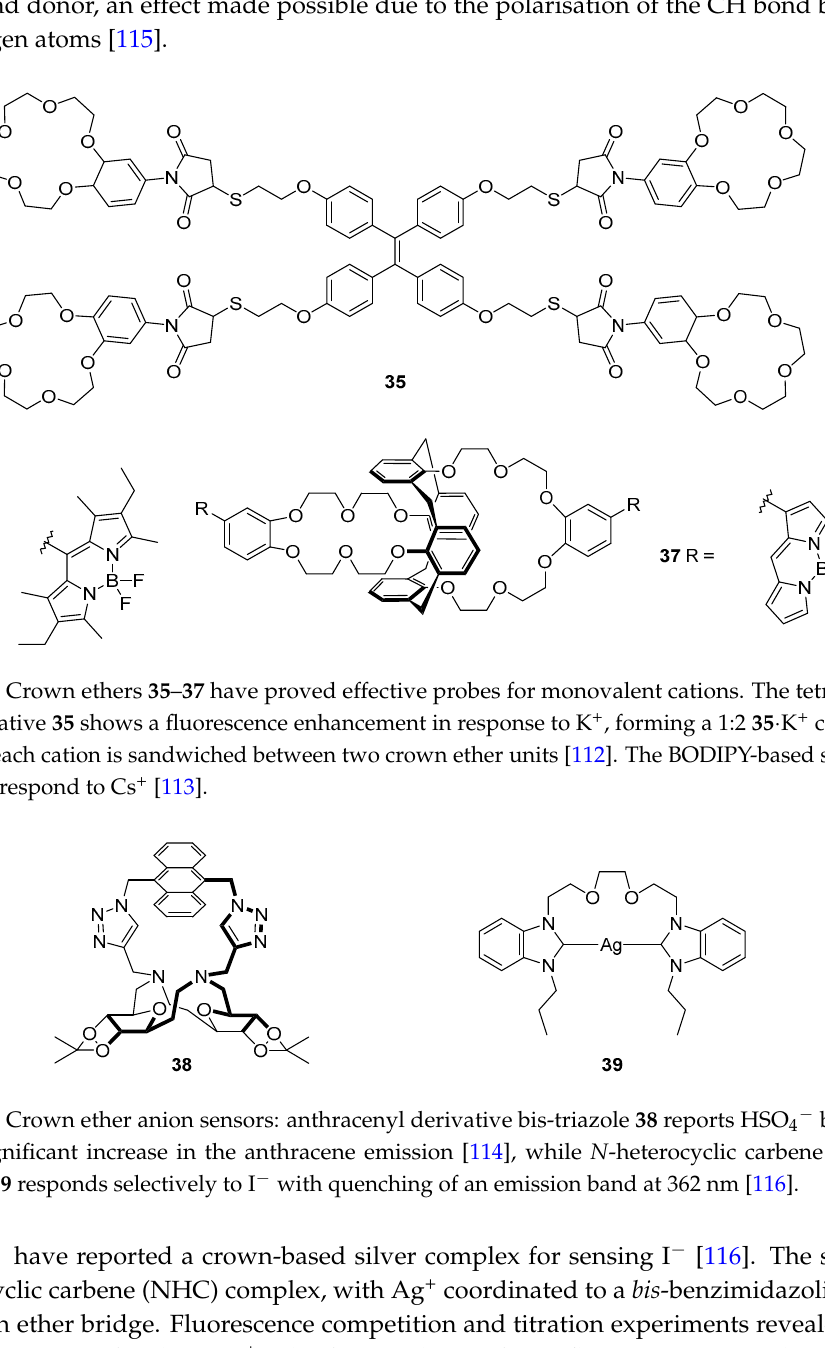
Figure 16. Crown ether anion sensors: anthracenyl derivative bis-triazole 38 reports HSO 4 − binding with a significant increase in the anthracene emission [114], while N -heterocyclic carbene (NHC) complex 39 responds selectively to I − with quenching of an emission band at 362 nm [116]. Liu et al. have reported a crown-based silver complex for sensing I − [116]. The sensor 39 is an